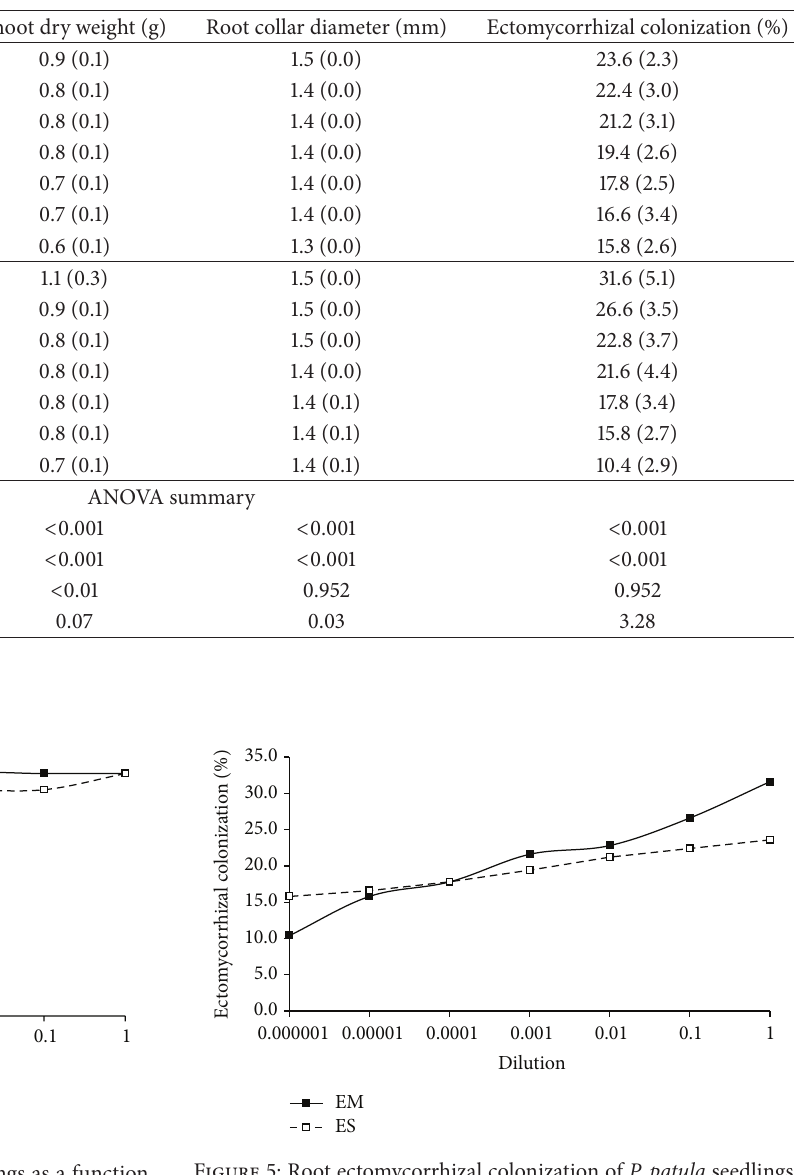
Table 2: Mean values forplant height, rootectomycorrhizal colonization, rootcollar diameter, and shoot dryweight inresponsetointeraction between inocula ( 𝐼 ) and dilution factors ( 𝐷 ). Standard deviations appear between parentheses.